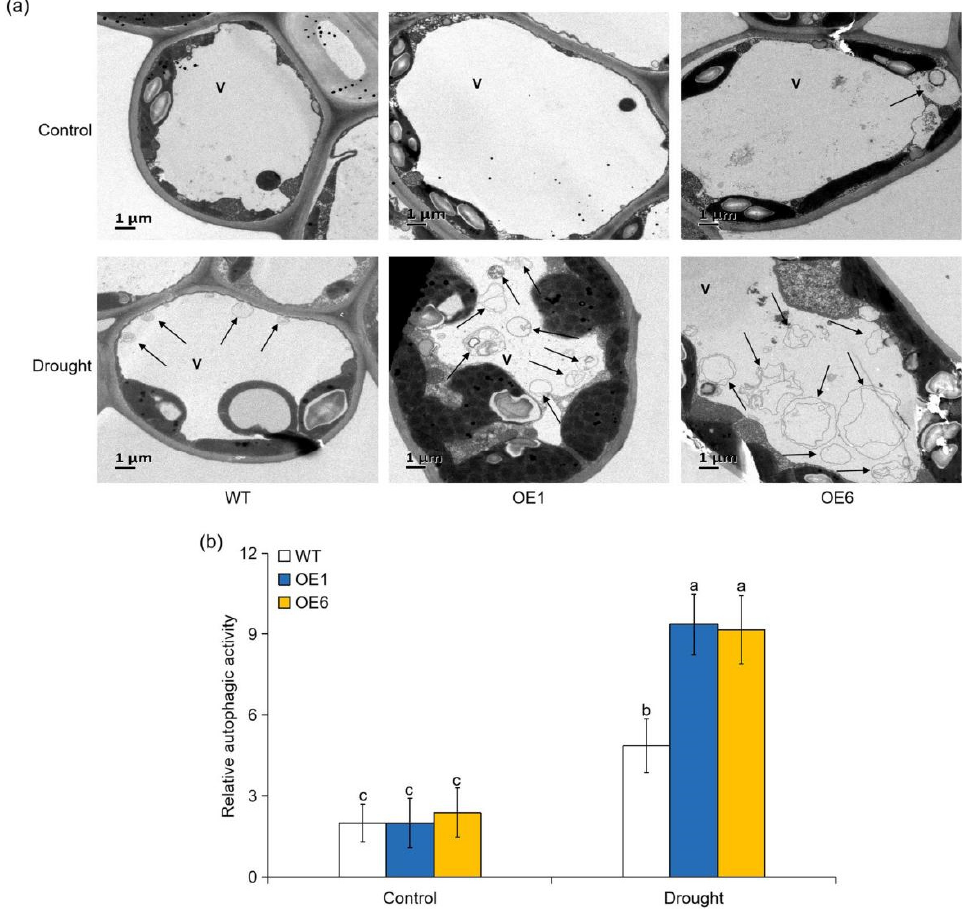
Figure 9. Effect of MdATG8i on the accumulation of autophagic structures in apple under drought conditions. ( a ) Representative images of autophagic structures in leaf mesophyll cells of WT and transgenic plants observed by TEM. V, vacuole. Autophagic structures are indicated by arrows. Scale bars: 1 μ m. ( b ) Relative autophagic activity quantified from the leaves of WT and MdATG8i OE plants as shown in ( a ). The data are presented as means ± SD of ten replicates. Values with different letters are significantly different ( p < 0.05, Tukey’s multiple range test).